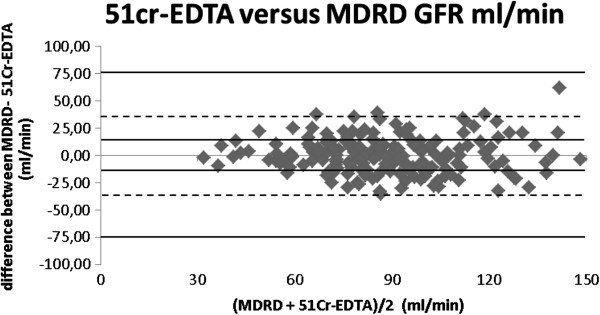
Bland altman plot 51cr-EDTA versus MDRD formula. 51cr-EDTA: 51 chromium ethylene diamine tretraacetic acid clearance; MDRD: Modification of diet in renal disease.